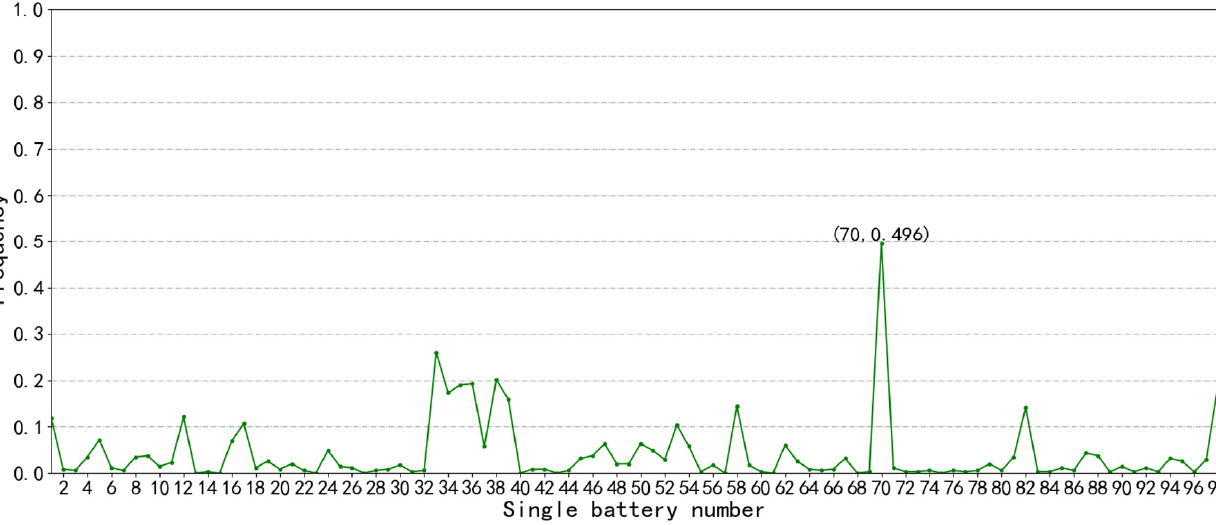
Figure 14. Frequency graph of sub-health state type I of single cells.